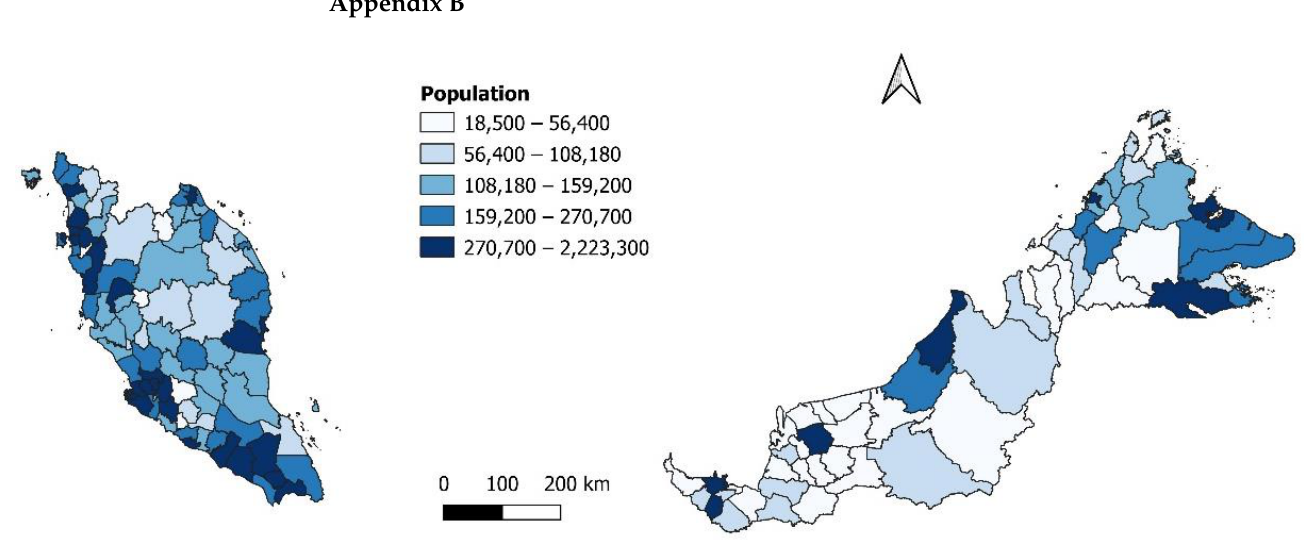
Figure A2. Absolute population by district, Malaysia (projected year 2020).